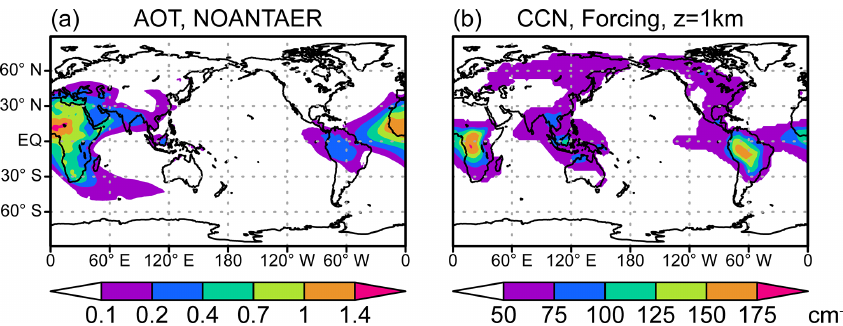
Figure 4. (a) Annual mean natural aerosol optical thickness averaged for June 2004–May 2005 as simulated by NICAM16-7S (NOANTAER run in Table 2). The data are gridded at 0.56 ◦ in longitude and latitude. (b) The annual mean number concentration of cloud condensation nuclei (CCN) from the natural origin at 1km above sea level prescribed for the model. The data are gridded at 2 ◦ in longitude and latitude and the unit is cm − 3 . The lower bound of CCN, 50cm − 3 (Sect. 2.3), is shown in white (no